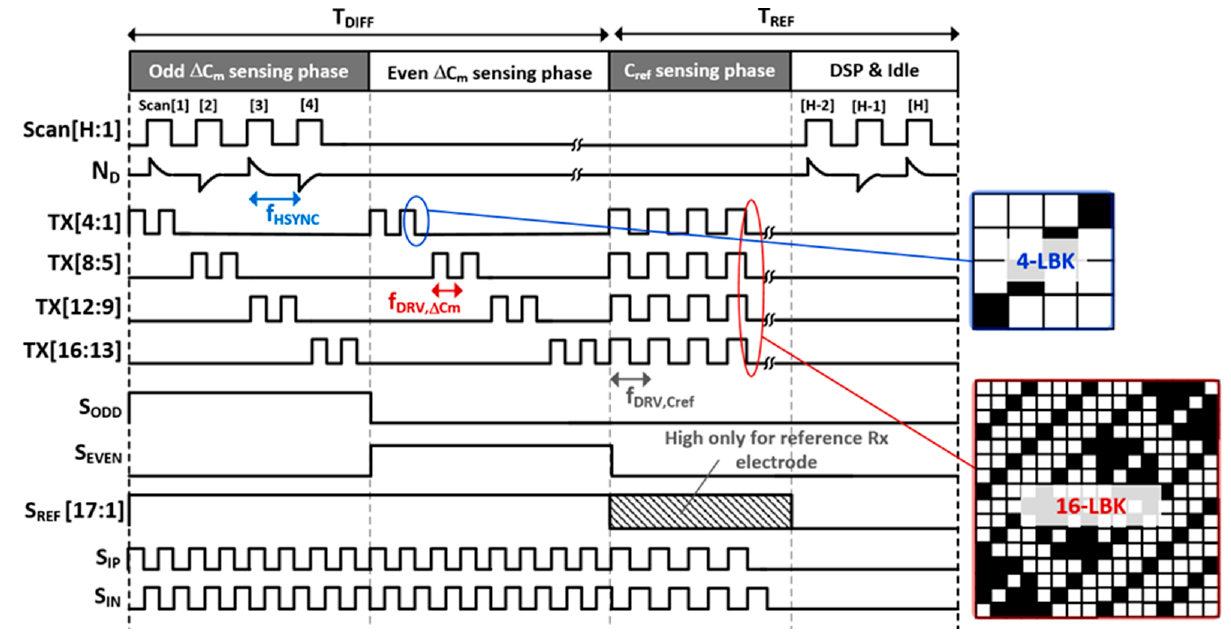
11 of 22 m s and ( b ) C ref s.